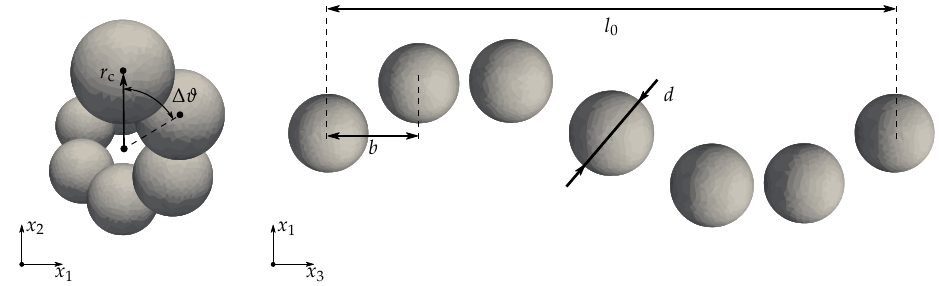
Figure 8. Schematic illustration of helical structures: front- and bottom-views with introduction of relevant geometrical parameters. The depicted structure represents a full helical chain with ∆ ϑ = 60°, = b = 6µm, d = 5µm and α = r c b